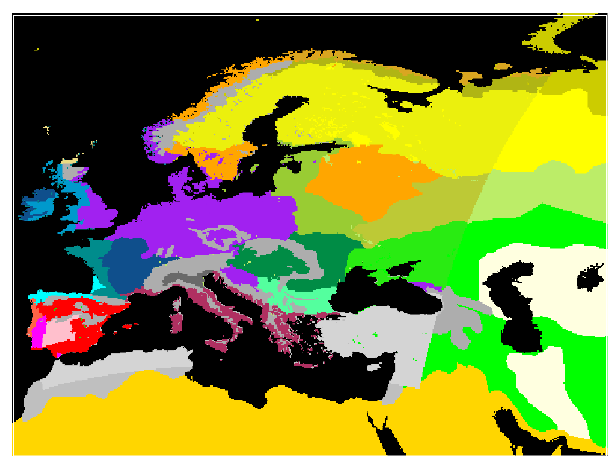
Fig. 3. Climate map built using the FIRS climate map completed by Figure 3. Climate map built using the FIRS climate map completed by the climate map of 13 the climate map of Koeppe and De Long (1958) for the eastern part Koeppe and De Long (1958) for the eastern part of the domain. 14 of the